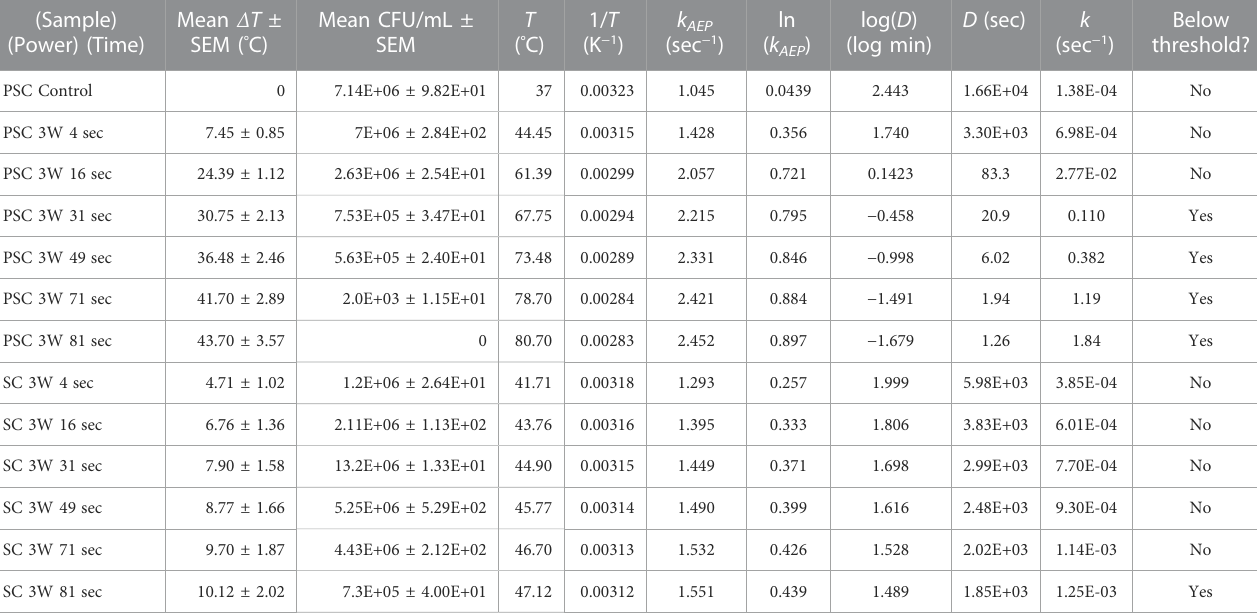
TABLE 1 Experimental post-treatment measurements alongside AEP model variables, and calculations derived from the van Asselt and Zweitiering model and indication of the where the surviving bacteria are above or below the survival threshold of 1E+06 CFU/mL. (Sample) (Power)